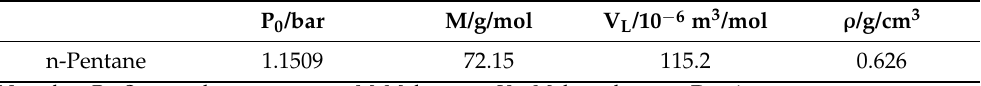
Table 1. Physical properties of n-pentane saturated vapor pressure (P 0 ), molar mass (M), molar volume (V L ), and density ( ρ ) at experimental temperature of 313 K